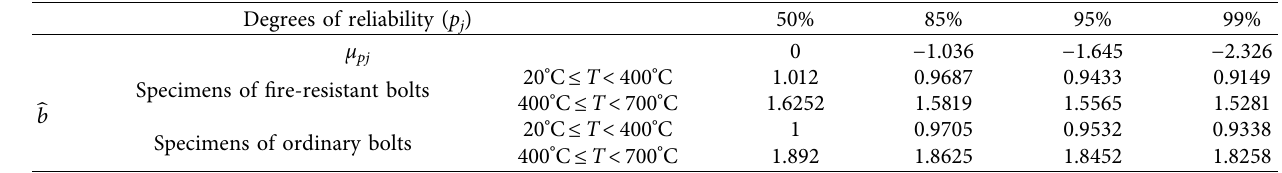
Figure 9: (a) Calculated model of K N . (b) Calculated model of K N for fre-resistant high-strength bolt specimens under diferent reliability. (c) Calculated model of K N for ordinary high-strength bolt specimens under diferent reliabilities. Table 6: Te model parameters of K N under diferent degrees of